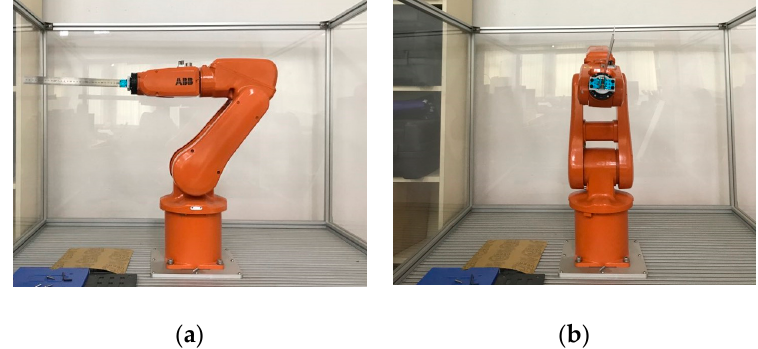
Figure 16. The experiment where the robot linearly moved while the configuration changed: ( a ) initial